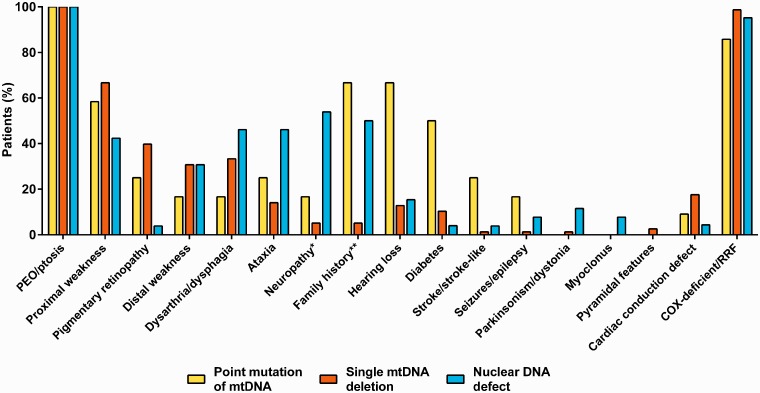
Frequency of clinical features of patients according to the genotype (n = 116). Forward slash indicates ‘and/or’. *Symptoms and/or signs suggestive of peripheral neuropathy. **Family history of relatives with similar symptoms or phenotype. COX-deficient/RRF = cytochrome c oxidase-deficient fibres and/or ragged-red fibres in muscle histochemistry.